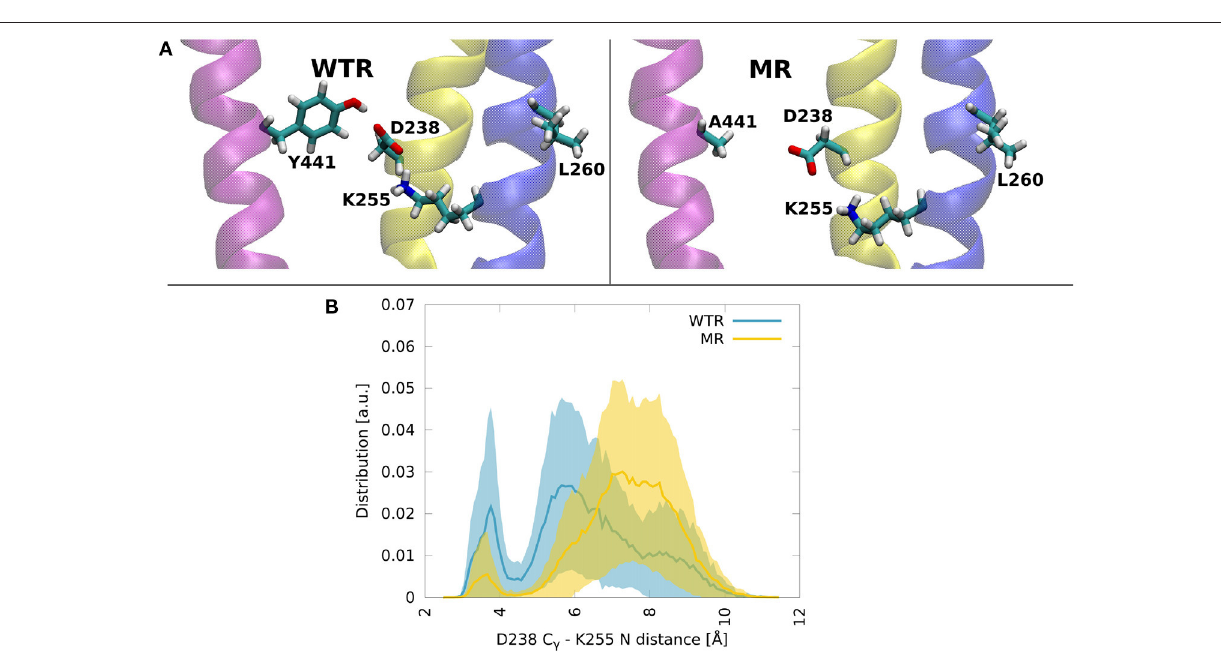
FIGURE 8 | (A) Molecular dynamics snapshots showing how Y441 might help maintain the hydrogen bonding between D238 and K255 in the WTR, while in the MR these two residues are less likely to form interactions. M1: yellow, M2: blue, M4: purple. (B) Distributions of the distance between C γ of D238 and the terminal nitrogen of K255, in the two models. Thick lines: averages; shaded area: